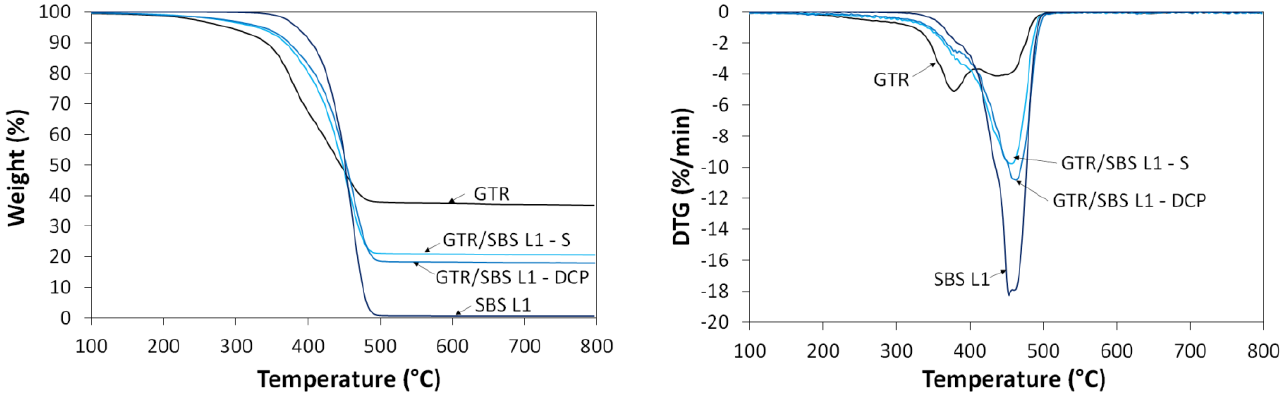
Figure 7. TGA and DTG curves for GTR/SBS blends.